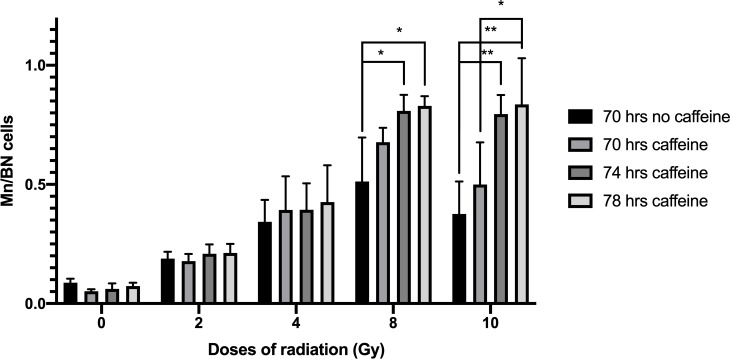
Micronuclei frequencies per binucleated cells after caffeine culture optimization at different doses of radiation.Error bars show SD from the 4 different donors. * indicates significant differences p<0.05 and ** indicates p<0.001.